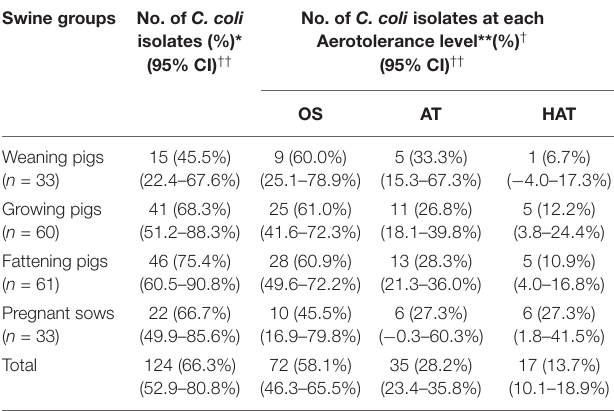
TABLE 1 | Prevalence of Campylobacter coli isolates according to the aerotolerance levels in each swine group. Swine groups No. of C. coli isolates